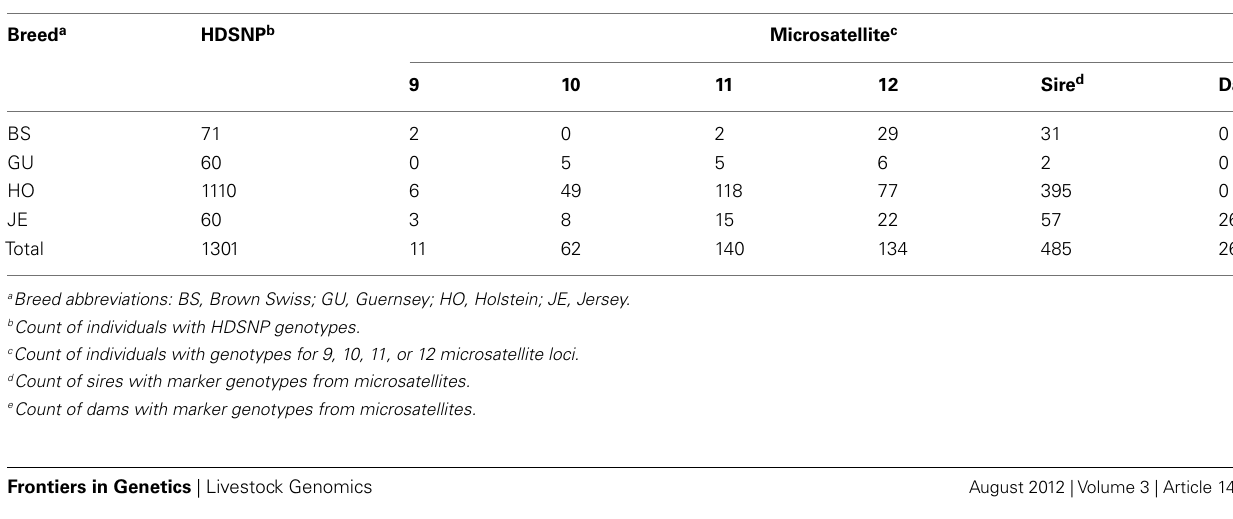
Table 1 |Animal and genotype count.